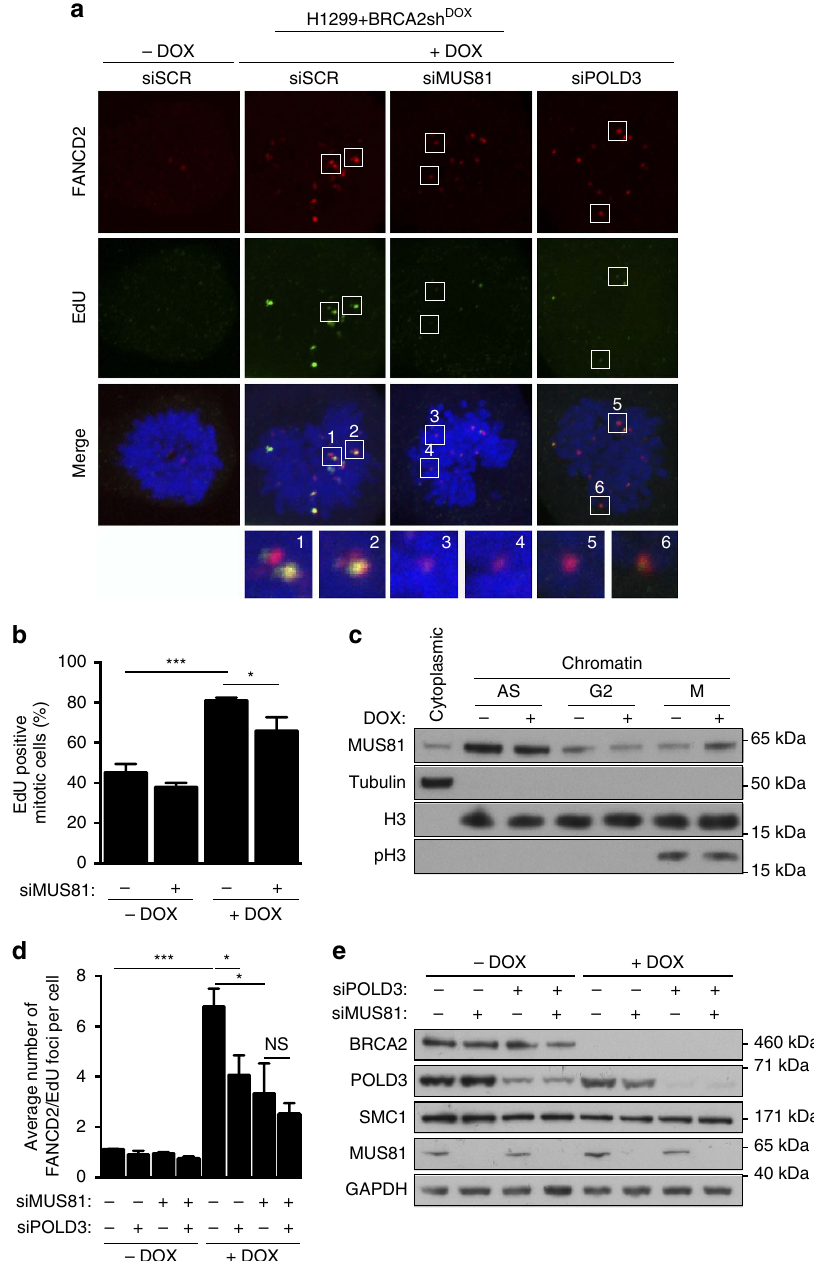
Figure 2 | MUS81 promotes DNA synthesis during mitosis in BRCA2-deficient cells. ( a ) H1299 cells carrying a DOX-inducible BRCA2 shRNA were transfected with control, MUS81 and/or POLD3 siRNAs. Cells were pulsed with EdU 72h later and processed for detection of EdU (green) and immunofluorescence staining with anti-FANCD2 antibody (red). DNA was counterstained with DAPI. ( b ) Quantification of the frequency of EdU-positive mitotic cells treated as in a . Error bars represent s.d. ( n ¼ 3). * P o 0.05; *** P o 0.001 (unpaired two-tailed t -test). ( c ) Western blot analysis of chromatin- bound fractions of indicated cell lines at indicated cell cycle stages. Histone H3 was used as a loading control for the chromatin fraction. AS, asynchronous; G2, G2-arrested; M, mitotic (prometaphase). ( d ) Quantification of the average number of FANCD2 foci co-localizing with EdU in mitotic cells treated as in a . Error bars represent s.d. ( n ¼ 3). * P o 0.05; *** P o 0.001 (unpaired two-tailed t -test). ( e ) Cell extracts prepared from samples analysed in d were immunoblotted as indicated. SMC1 and GAPDH were used as loading